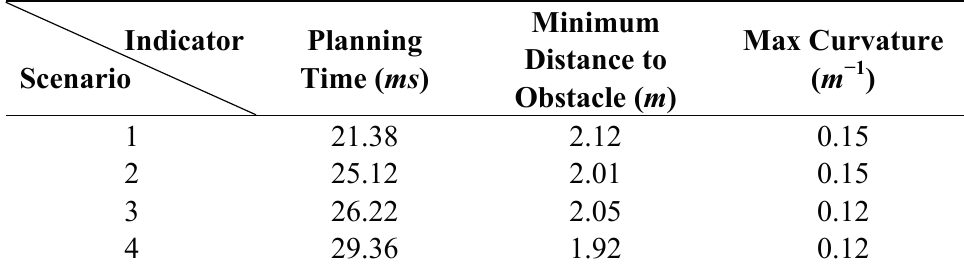
Table 1. The main evaluation indicators of motion planning results.